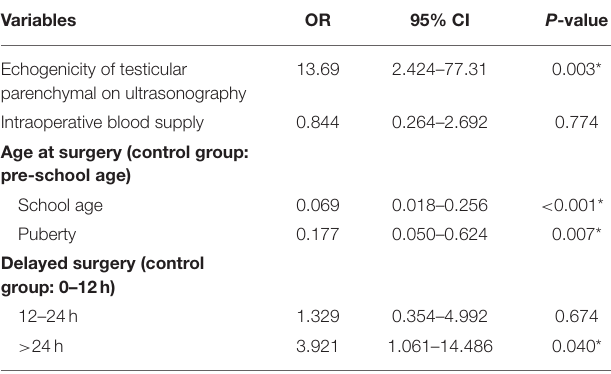
TABLE 2 | Multivariate logistic analysis of testicular